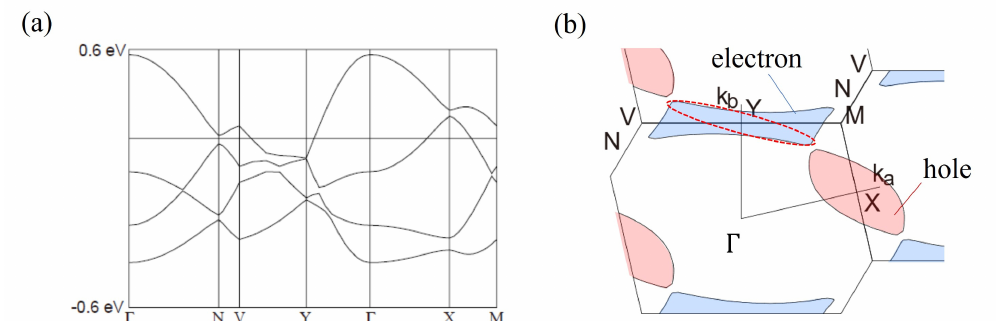
Figure 3. ( a ) Band structure by an extended Huckel method and ( b ) 2D Fermi surface structure for the β (cid:48)(cid:48) -SF 5 salt. Deformed square hole and elliptic electron pockets were formed. The red dotted curve indicates the 2D Fermi surface determined by the AMRO